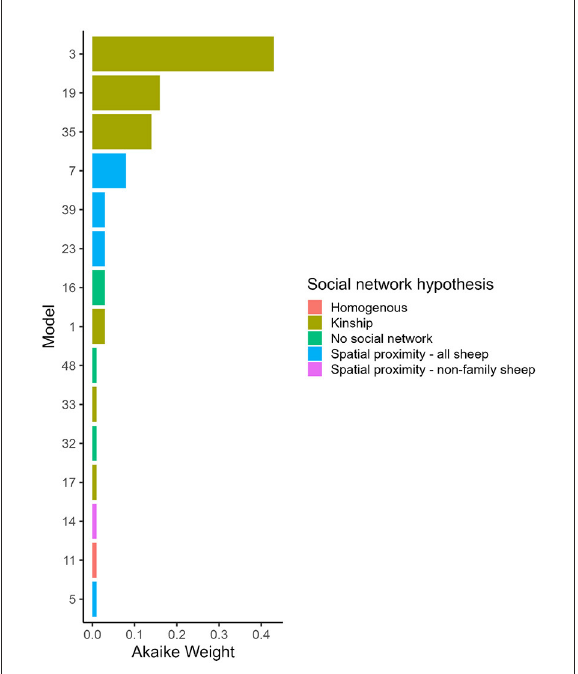
FIGURE2 Akaike Weight for models with different social network predictors and combinations of variables affected social and asocial transmission. Models are ordered by Akaike Weight and are shown if the Akaike Weight was > 0.00. 1. Full descriptions of the models are in Table 1 and the full set of Akaike Weights are in Table 4. Akaike Weight is the probability the model is the best Kullback-Leibler model in the